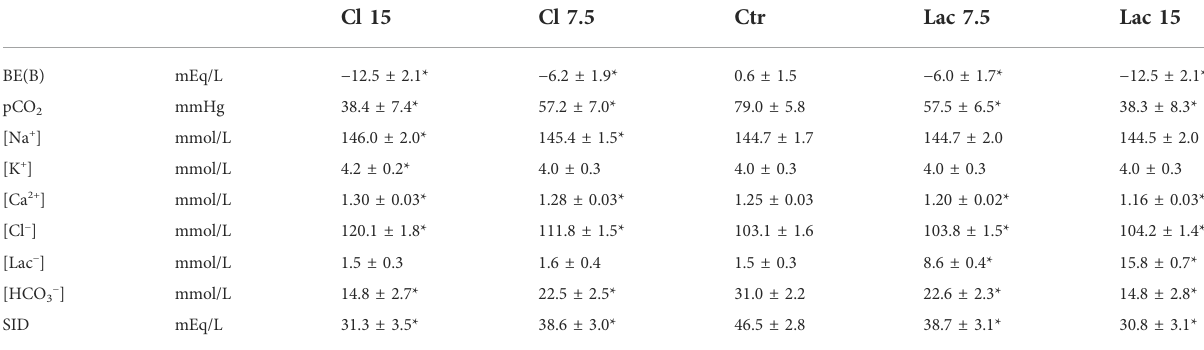
TABLE 1 Characteristics of blood aliquots treated with the stock solutions. As most of the parameters change during the CO 2 tonometry, values obtained by interpolation for pH = 7.2 are reported. Statistically signi fi cant difference from Ctr is marked by an asterisk (*).